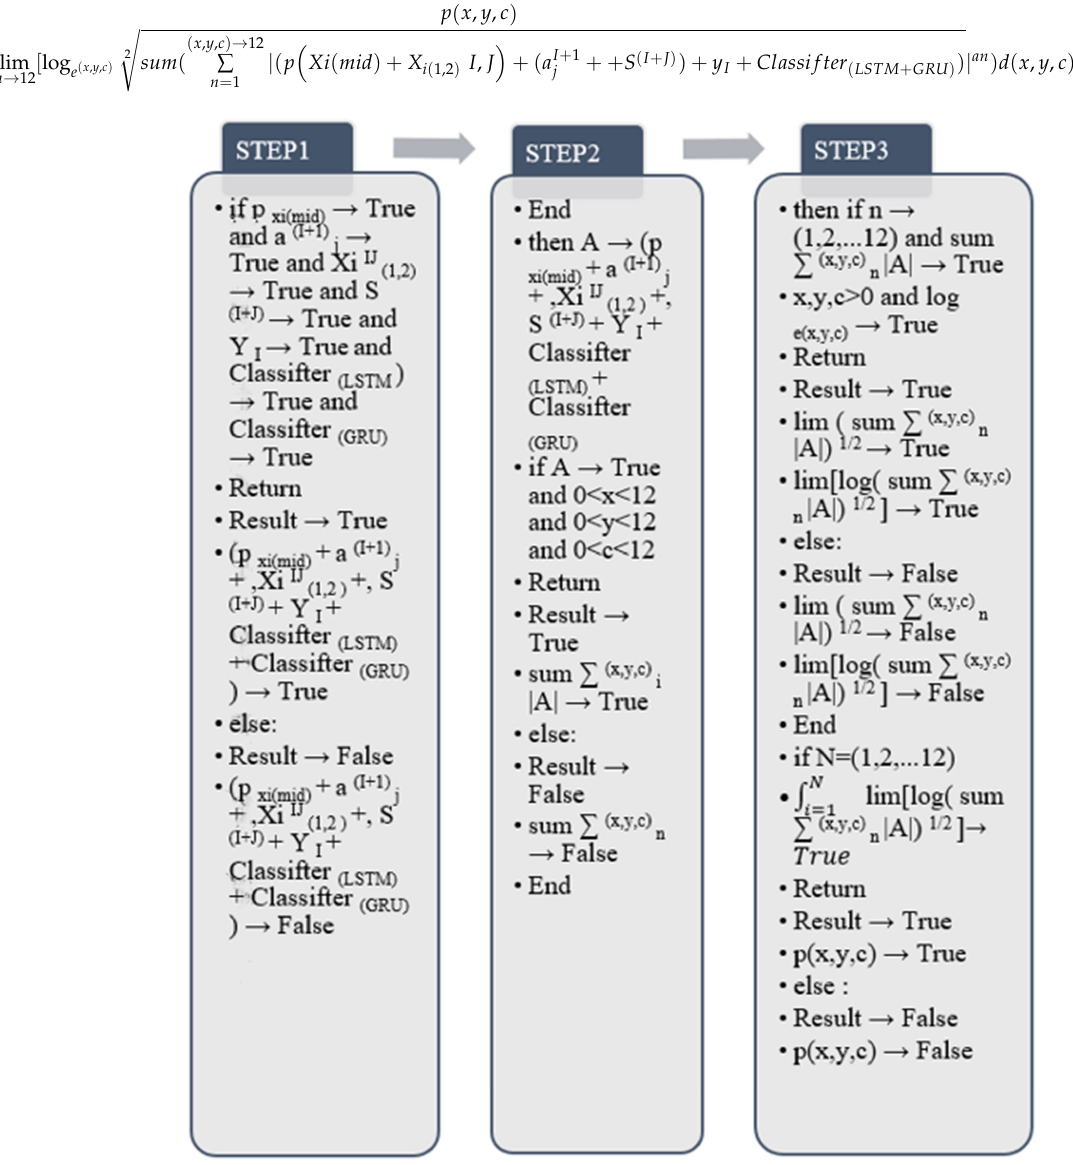
Figure 26. The output diagram of the improved algorithm of the Python main program.